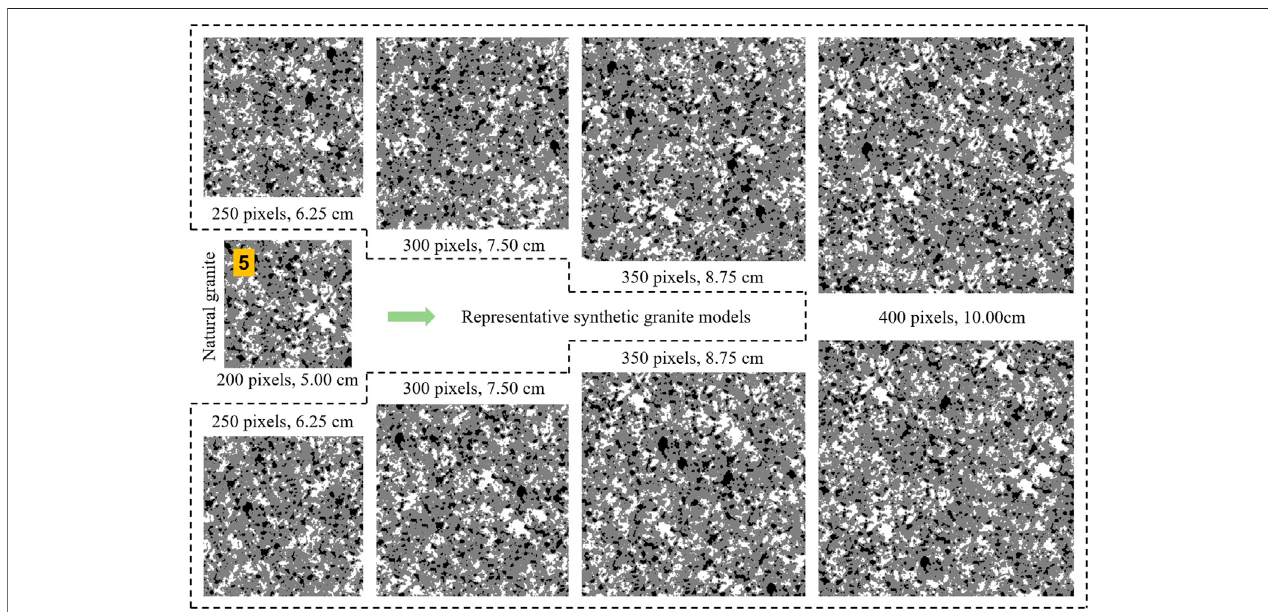
FIGURE 9 | Enlarged synthetic granite models from a single natural granite.